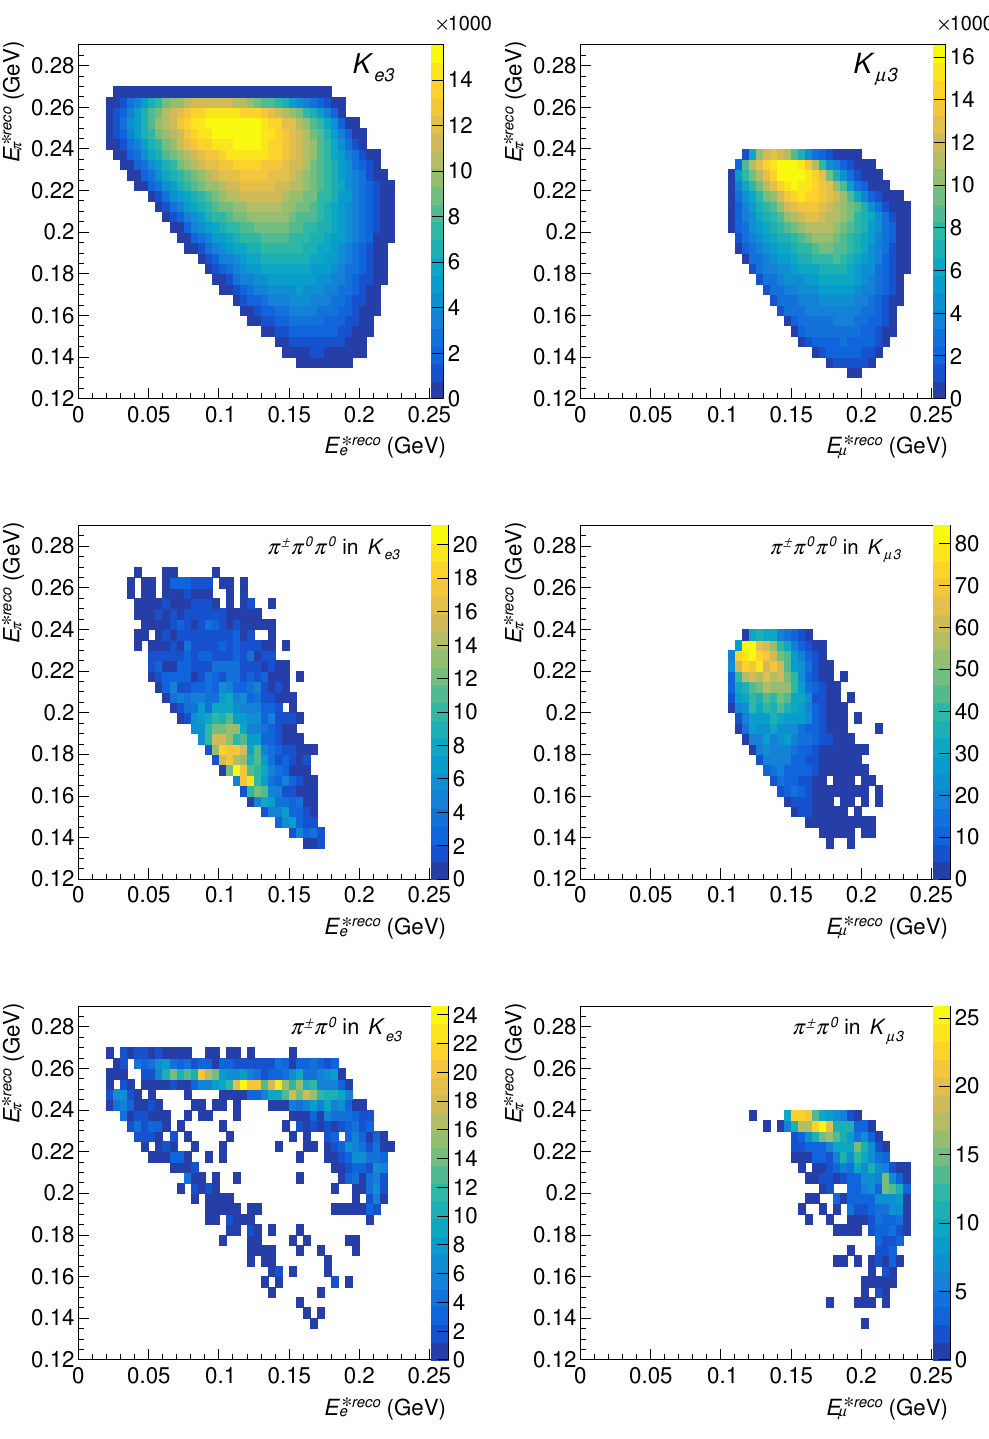
Figure 6 . Dalitz plot distributions after the full selection of reconstructed K (cid:6) data events (top l 3 row), simulated K (cid:6) ! (cid:25) (cid:6) (cid:25) 0 (cid:25) 0 (middle row) and K (cid:6) ! (cid:25) (cid:6) (cid:25) 0 (bottom row) background events. Left panels correspond to the K (cid:6) selection and right panels to the K (cid:6) selection. The simulated e 3 (cid:22) 3 backgrounds are normalized to the total kaon (cid:13)ux in the data. The cell size is 5 (cid:2) 5 MeV 2 .